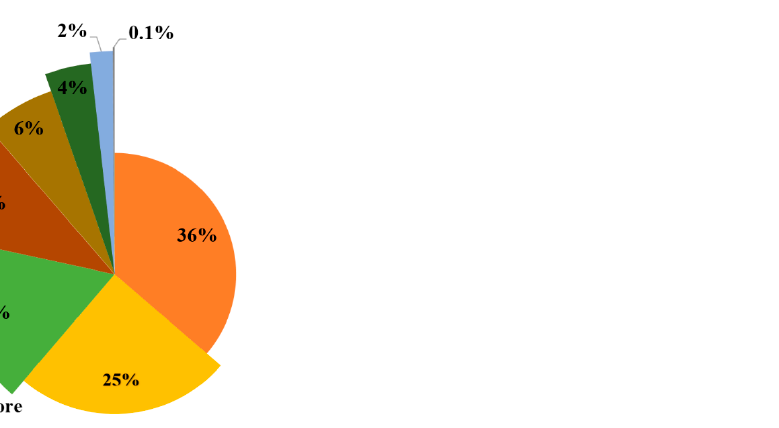
Figure 5. The share of people living on different floors of the buildings for the city of Baharestan.